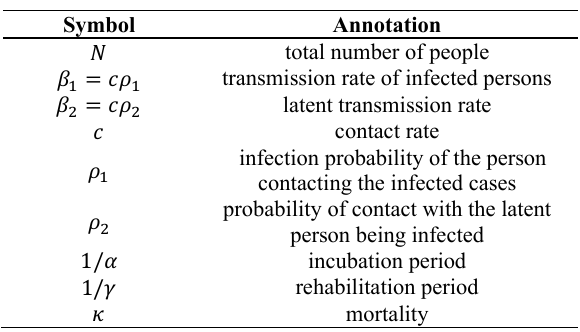
Table 1. The mathematic symbols and the annotations